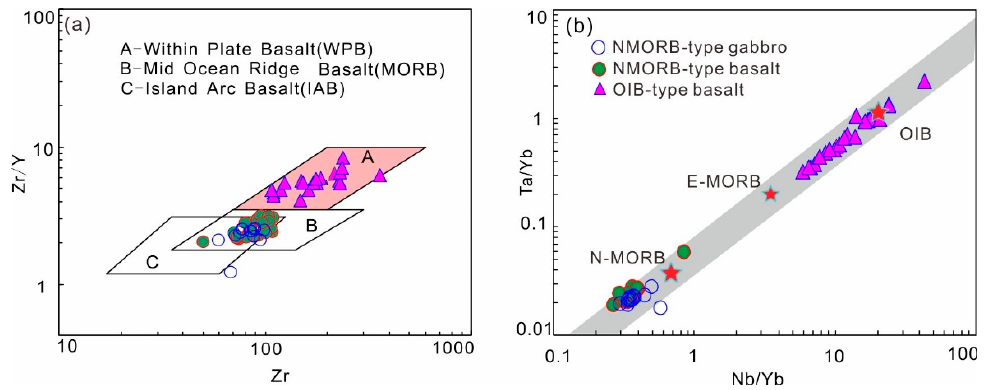
Figure 9. ( a ) Zr vs. Zr/Y and ( b ) Nb/Yb vs. Ta/Yb diagrams for mafic magmatic rocks.